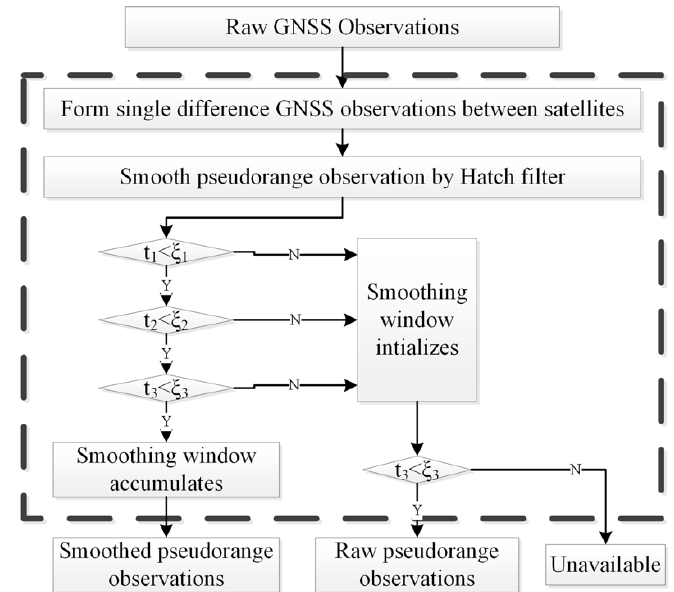
Figure 2. The architecture of TT-SD (Three-Thresholds and Single-Difference) Hatch filter algorithm